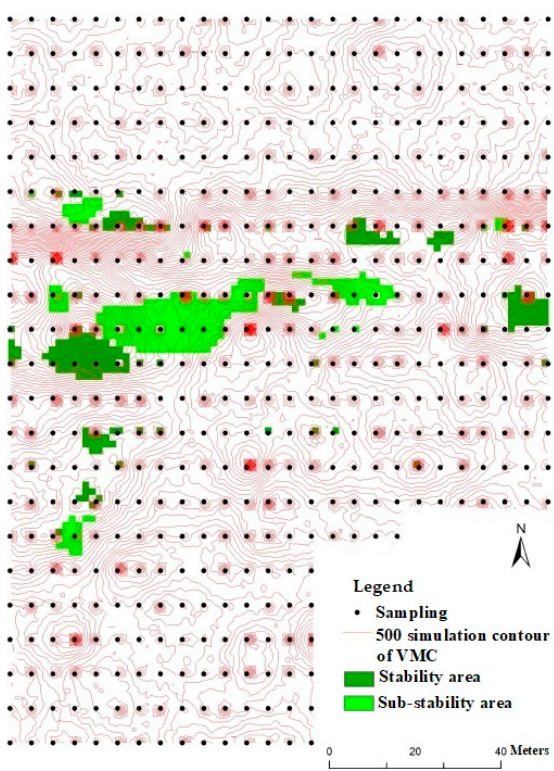
Figure 11. Overlay map from 500 simulation contours of VMC with SGS in the jointing stage with a stable area grid of VMC.